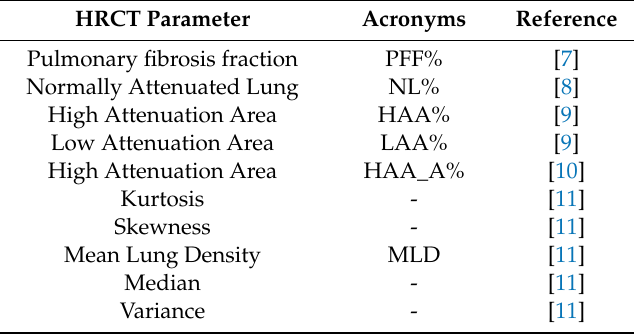
Table 1. State-of-the-art-parameters obtained from HRCT found in recent literature. In the specific, high-attenuationarea(HAA)%[9]isdefinedasareaswithattenuationvaluesgreaterthan − 200HounsfieldUnit (HU). HAA_A% [10] is defined as the percentage of the whole lung volume with a density between − 250 and − 600 HU. Pulmonary fibrosis fraction (PFF), normally attenuated lung (NL), HAA, LAA, and HAA parameters are expressed in percentage values (%) while kurtosis, skewness, mean lung density, median, and variance are expressed in absolute values. HRCT Parameter